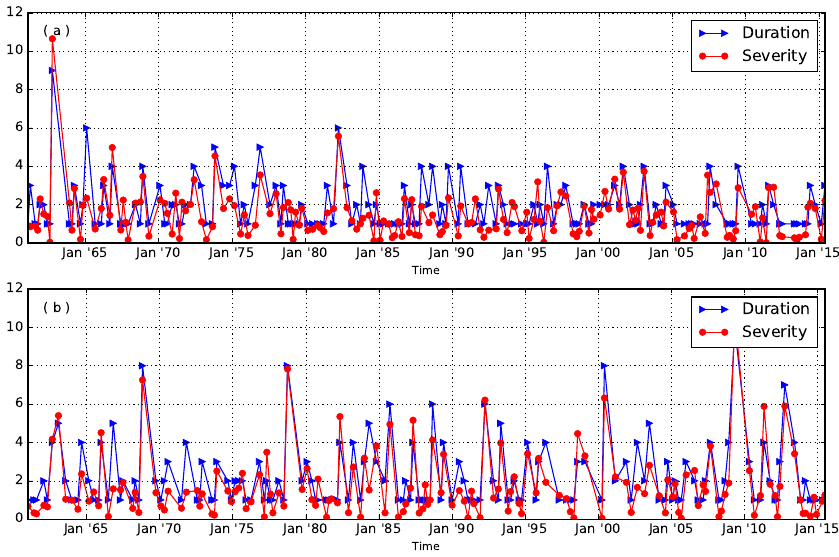
Figure 3. The time sequences of drought duration and severity: ( a ) Changchun (station No. 54161); ( b ) Maerkang (station No.